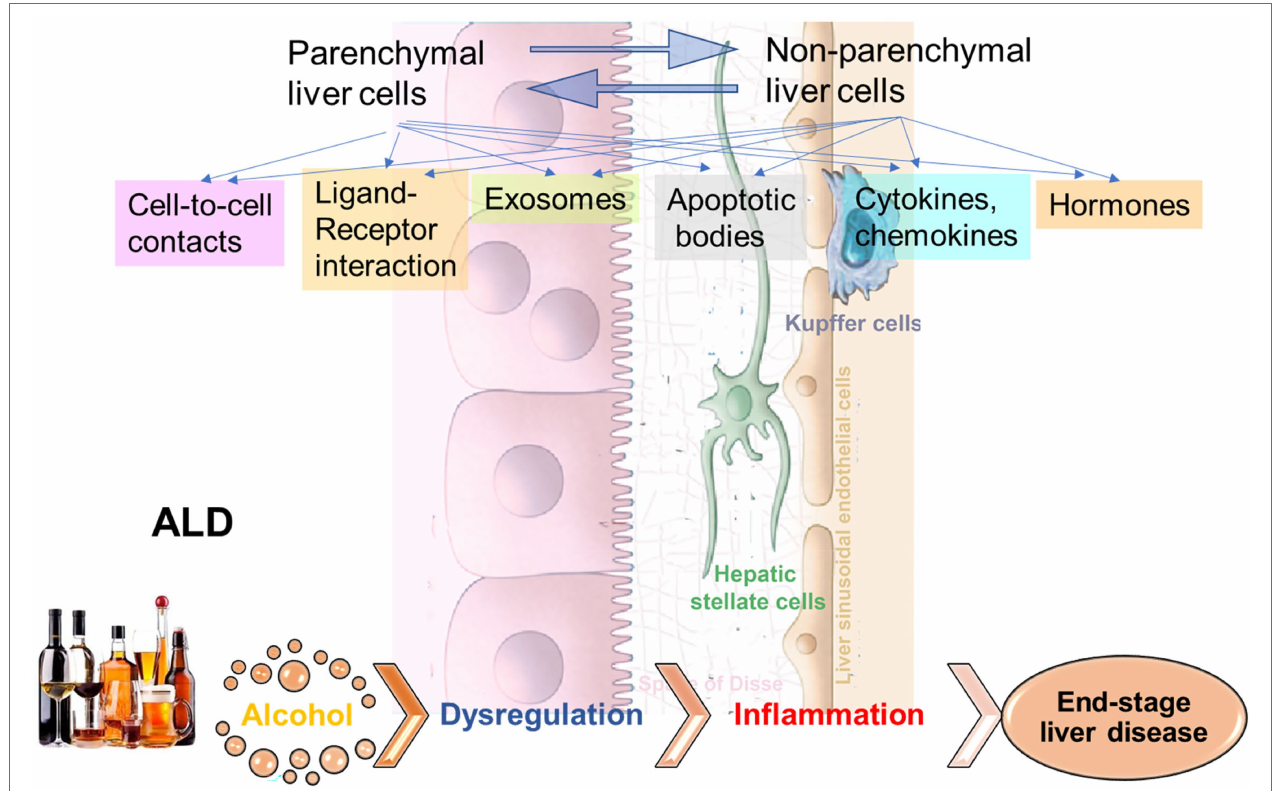
FIGURE 1 | Cell-to-cell communications in ethanol-related progression to end-stage liver diseases. The signals to activate the crosstalk between liver parenchymal and non-parenchymal cells can come via direct cell-to-cell interactions, via ligand-receptor interactions, exosomes, apoptotic bodies, cytokines/chemokines, hormones, etc. Exposure to alcohol, especially, ethanol metabolites induce activation of signal transduction pathways in recipient cells, thereby altering their functions, which leads to liver inflammation and fibrosis development, with progression to end-stage liver